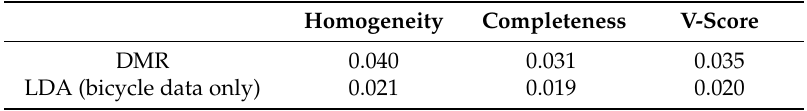
Table 4. The comparison of POI included model (DMR) and excluded model